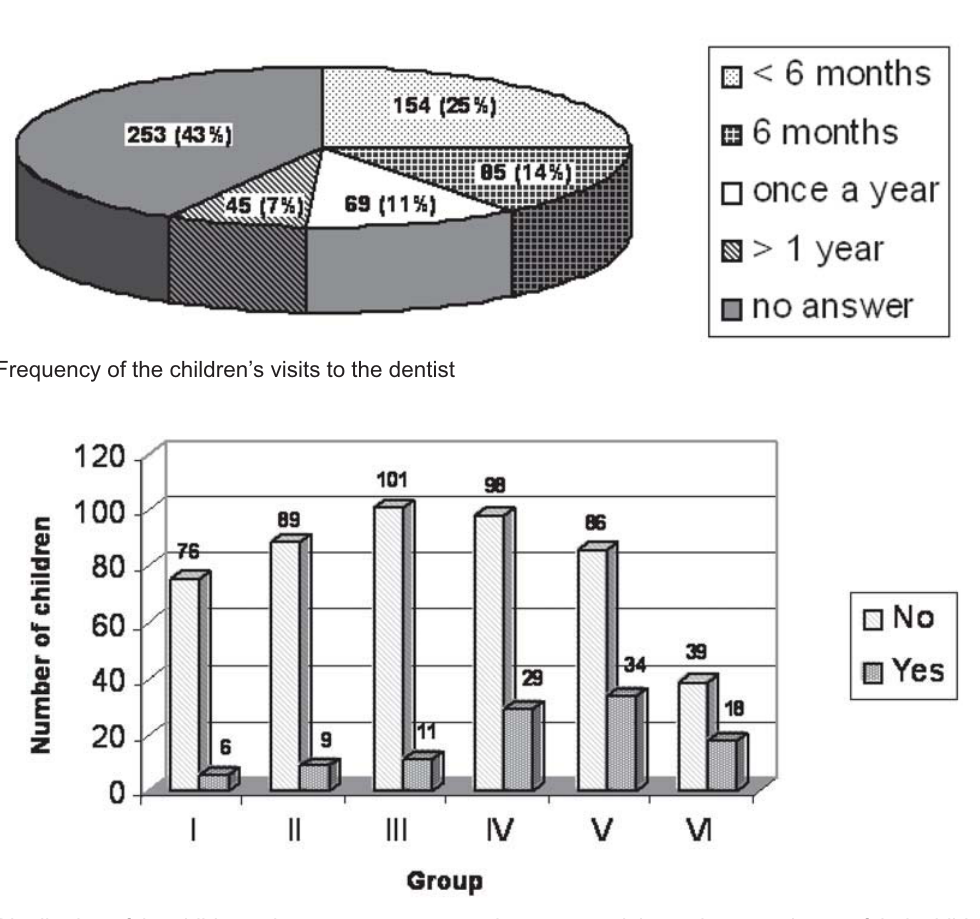
FIGURE 4- Distribution of the children whose parents or caretakers reported the caries experience of their children, according to their